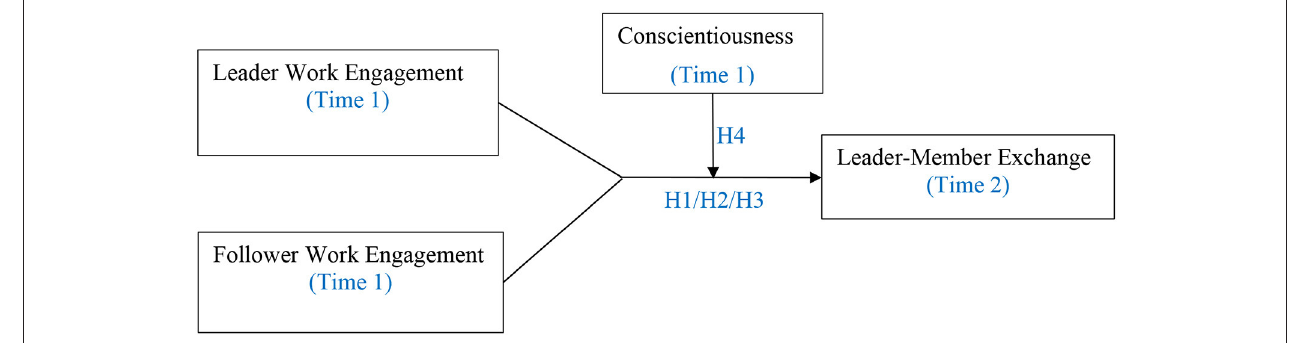
FIGURE 1 | A hypothesized